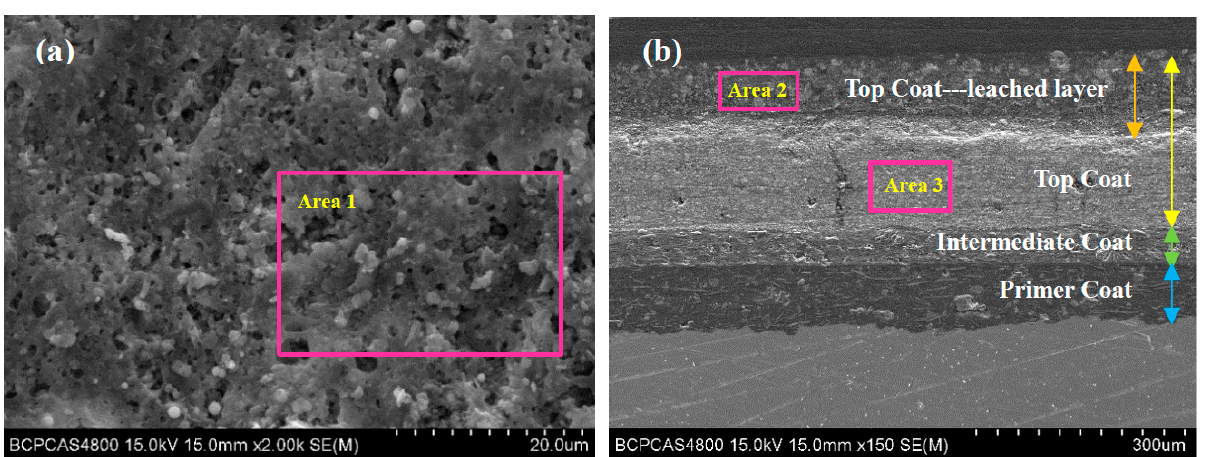
Commented [M1]: Please help replace Figure 4. Figure 4. SEM morphology of FW1 coating sample after 1700 d: ( a ) the surface of antifouling coating;